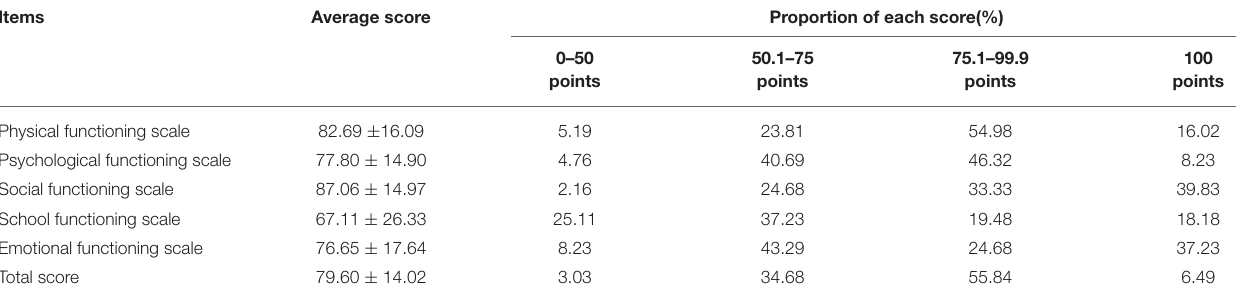
TABLE 2 | The survey results by PedsQL TM 4.0 Pediatric Quality of Life in children with PNS.